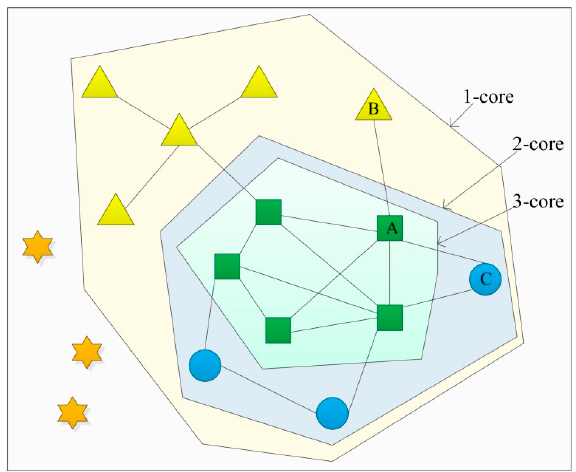
Figure 4. Illustration of k ‐ core decomposition method.